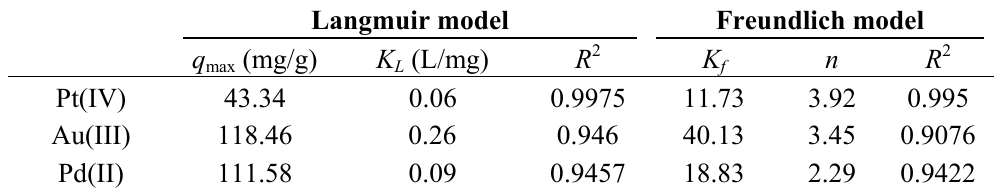
Table 1. Langmuir and Freundlich constants of MNP-Tu adsorption for various precious metals. Langmuir model Freundlich model